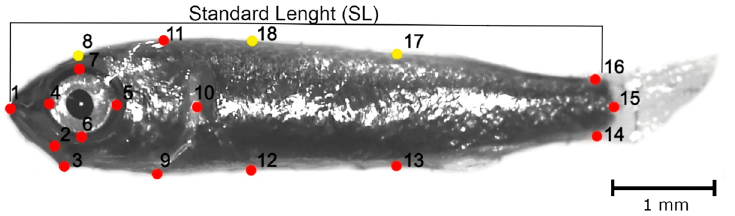
Figure 1. Location of selected landmarks (red dots) and semilandmarks (yellow dots) to describe body shape in C. auratus specimens of 24 dph. L1, anterior tip of the premaxilla; L2, posterior tip of the premaxilla; L3, angle of the lower jaw; L4, anterior margin in the eye; L5, posterior margin in the eye; L6, inferior margin in the eye; L7, superior margin in the eye; L8, dorsal margin of the head; L9, ventral margin in the end of the head; L10, posterior margin in the end of the head; L11, dorsal margin in the end of the head; L12, insertion of the pelvic fin; L13, anterior insertion of the anal fin; L14, ventral insertion of the caudal fin; L15, central of the caudal fin; L16, dorsal insertion of the caudal fin; L17, dorsal projection of the landmark 13; L18, dorsal projection of the landmark 12. Digitalization of these points was performed using the software tpsDig v. 1.81 [34],